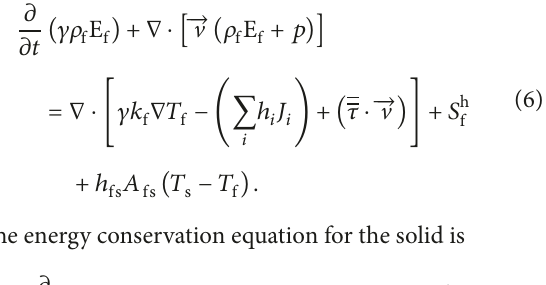
cross flow in the radial directions. Therefore, the resistance coefficients in the other two directions were specified to be 1000 times the axial flow resistance coefficients to suppress the radial